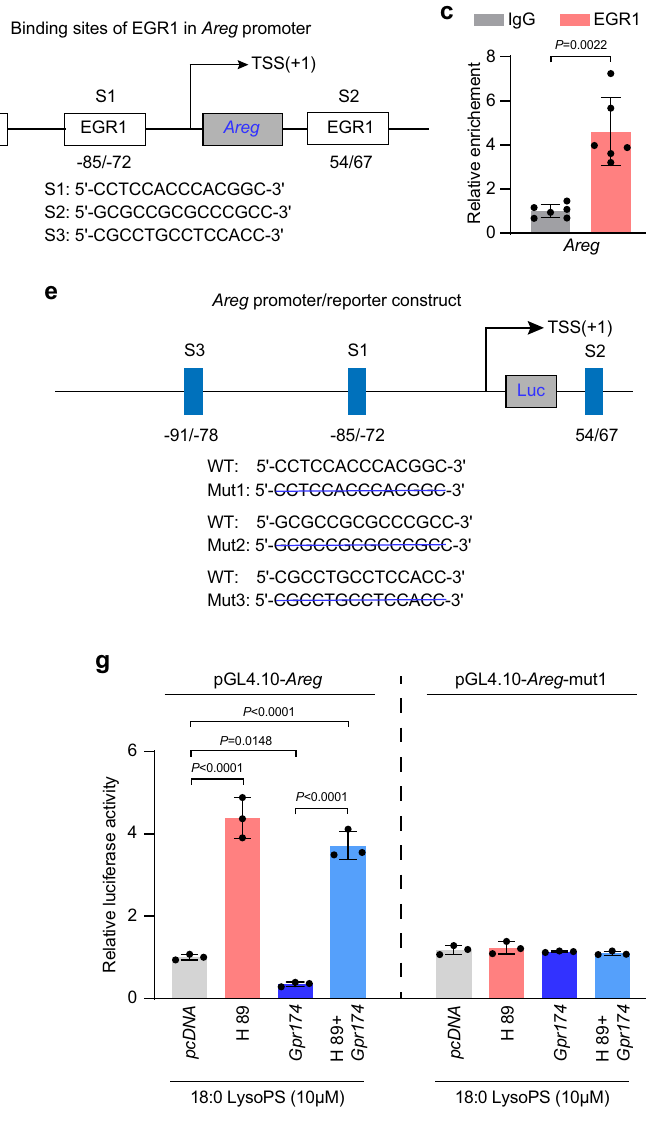
Fig. 7 | GPR174 inhibits AREG transcription activation via PKA/EGR1 pathway. a Consensus DNA-binding motifs of EGR1 according to JASPAR database. b The predicted binding sites of EGR1 in Areg promoter according to JASPAR database. c ChIP-qPCR assay in HEK293A cells for EGR1 or IgG occupancy at Areg promoter fragments ( n =6). d ChIP-qPCR assay in HEK293A cells transfected with Gpr174 CRISPR Activation Plasmidfor EGR1 or IgG occupancy at Areg promoterfragments ( n =3). e Generation of luciferase reporters governed by Areg promoter with wild- typeormutantEGR1bindingsites; f DualluciferasereporterassayinHEK293Acells